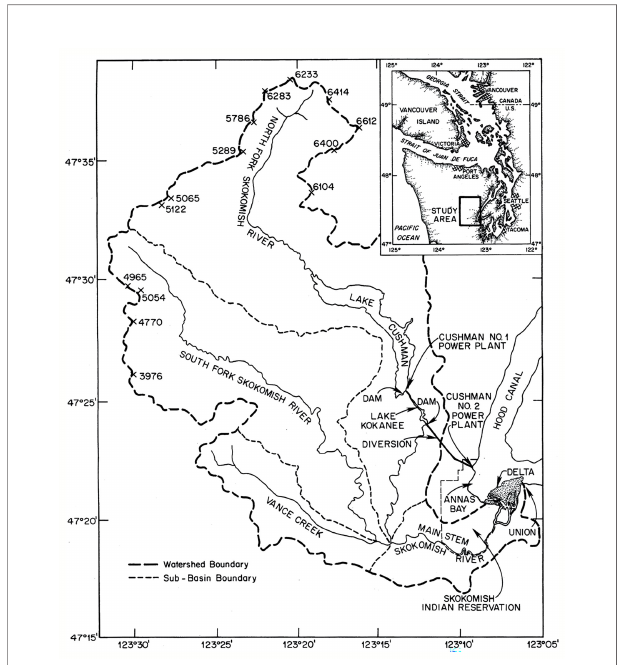
FIGURE 4 | Local Watershed Map (Source: Jay and Simenstad